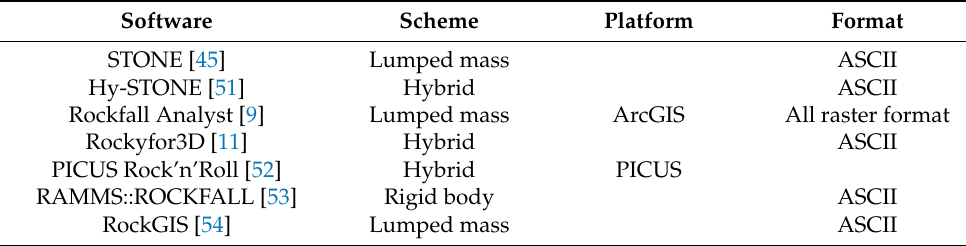
Table 1. Rigid body programs on GIS